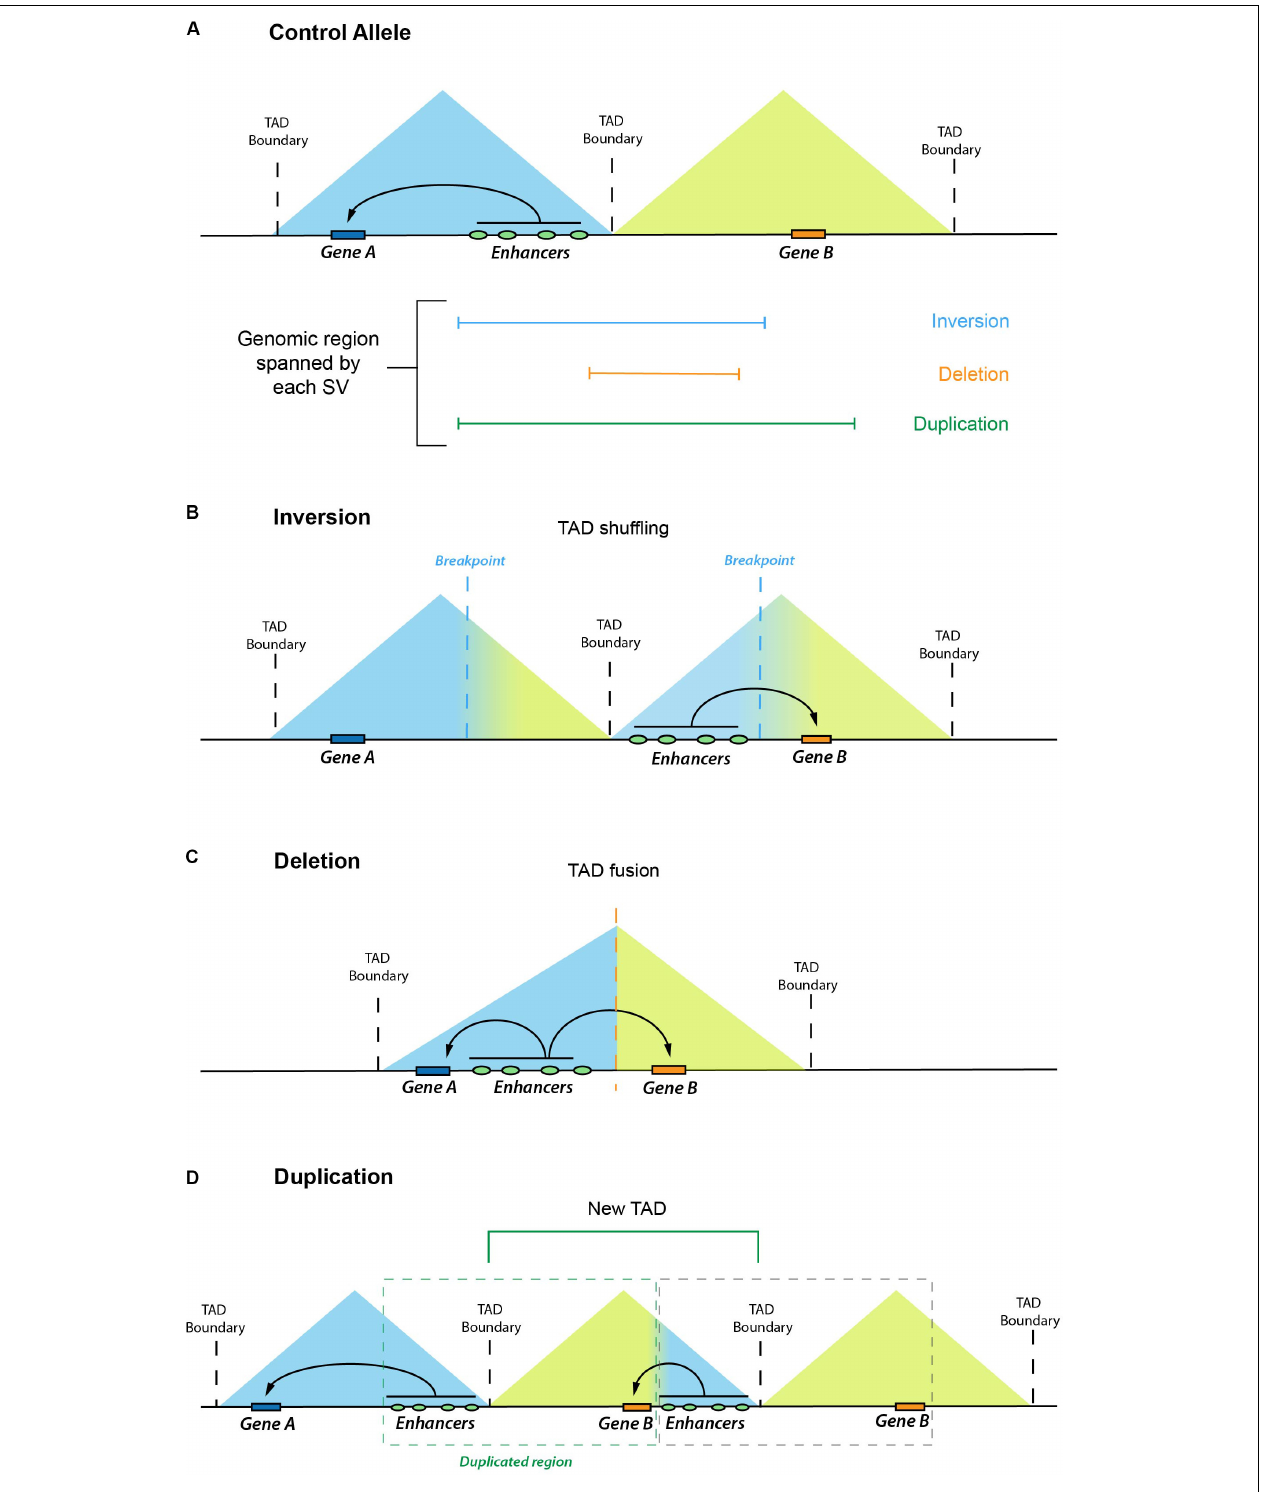
FIGURE 1 | Enhancer adoption as a result of different structural variants (SV). Graphical overview of how different types of SV can lead to enhancer adoption mechanisms. In the control allele (A) , Gene A and Gene B are located in two neighboring TADs. In (B–C) , we illustrate how different genomic rearrangements, such as inversions (B) , deletions (C) , or duplications (D) , can remodel the 3-D chromatin landscape (through processes, such as TAD shuffling, TAD fusion, or formation of a new TAD, respectively) and increase Gene B expression due to the regulatory effects of ectopic enhancers.